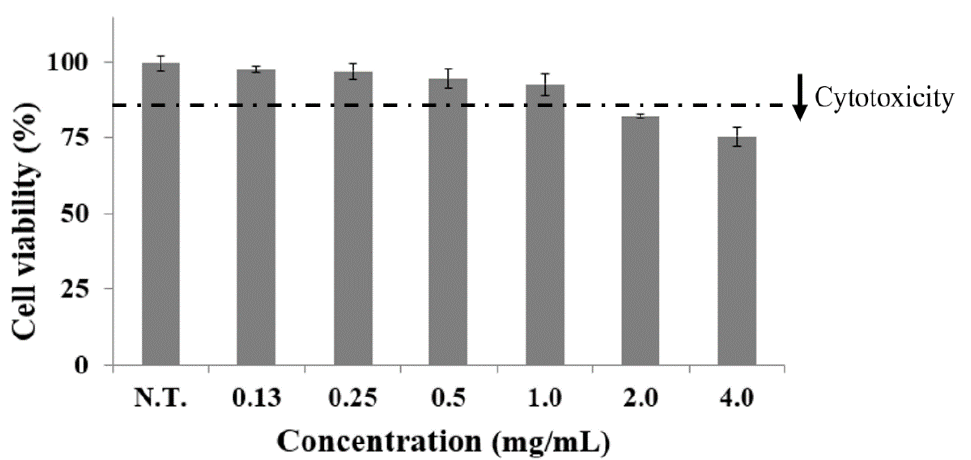
Figure 1. Effects of C. gladiata extract (0.0~4.0 mg/mL) on cell viability in preadipocytes. Bars represent the mean ± standard deviation of three independent experiments and asterisks indicate significant differences from the control.